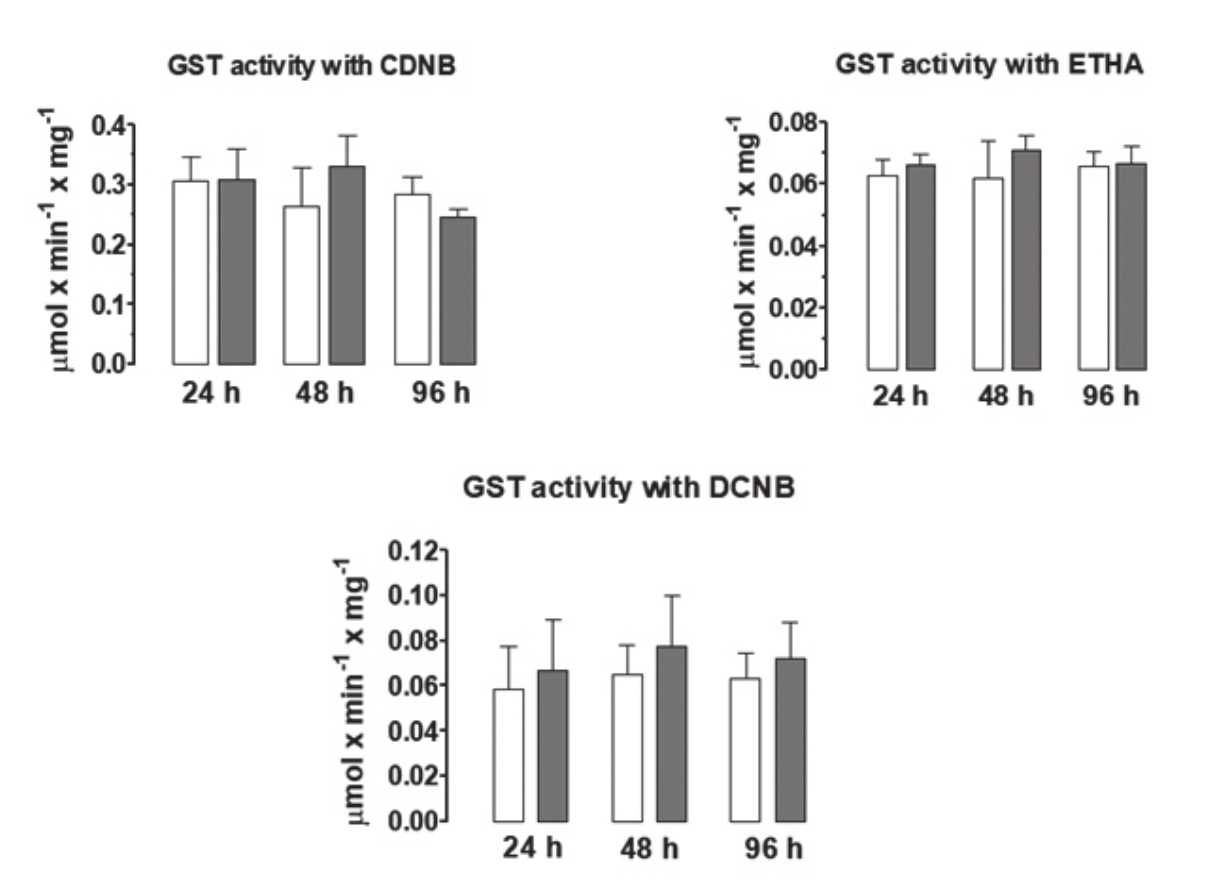
FIGURE 2 | GST specific activities in kidney cytosol from Piaractus mesopotamicus injected with methyl parathion (8 mg kg -1 ). Assays were carried out with 1-chloro-2,4-dinitrobenzene (CDNB), ethacrynic acid (ETHA) or 2-dichloro-4-nitrobenzene (DCNB) at 24, 48 and 96 hours after the injection. Bars represent the means ± S.E.M. of assays from five fish injected with corn oil (clear) or methyl parathion (dark